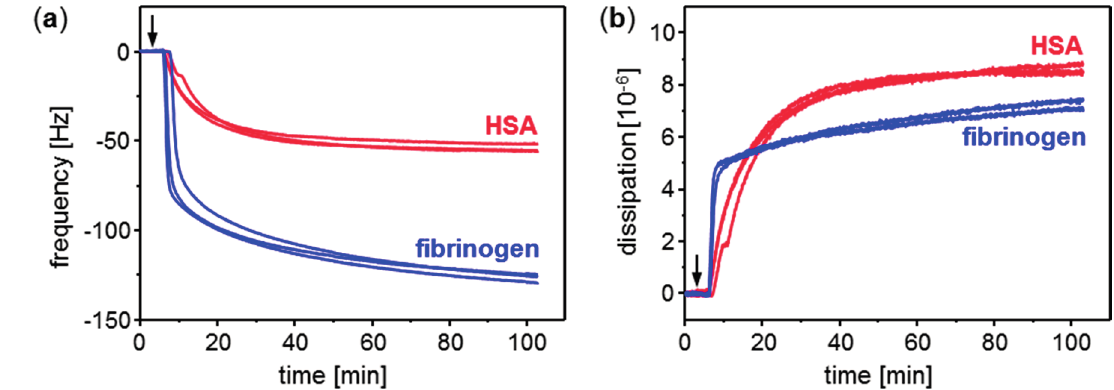
Figure 7. Conditioning film monitoring with QCM sensors coated with parylene C: Adsorption of plasma proteins HSA (red curves) and fibrinogen (blue curves). Samples contained 250 µg/mL protein in PBS. The PBS carrier stream was switched to sample solution 3 min after start of the measurement (see arrow). ( a ) Frequency; ( b )